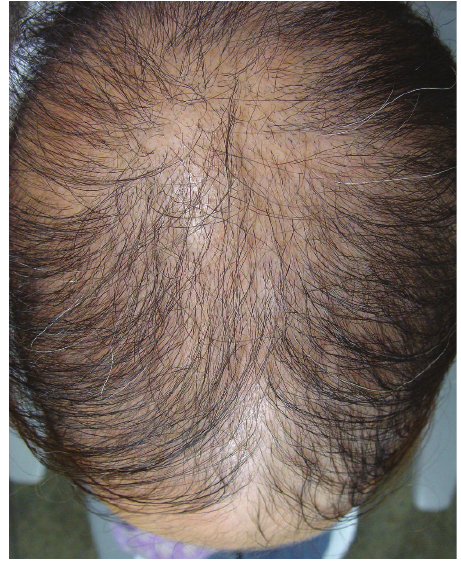
Figure 1 - Clinical picture at 2 weeks from the onset of hair shedding.